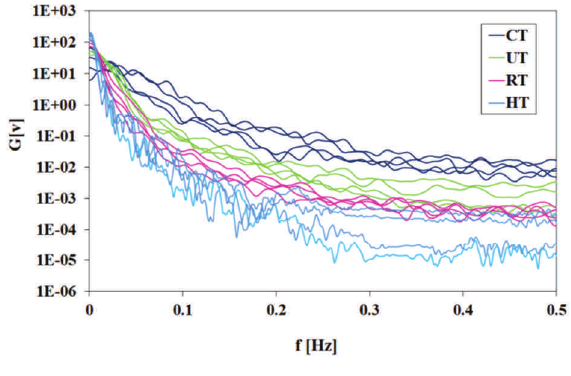
Fig. 6. Comparison between the curves representing the power spectral density of standardized velocity (G[v]) in the frequency domain (f) for all